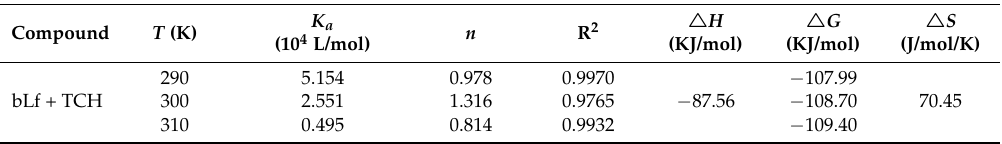
Table 2. The thermodynamic binding parameters of the interaction between bLf and TCH at different temperatures.